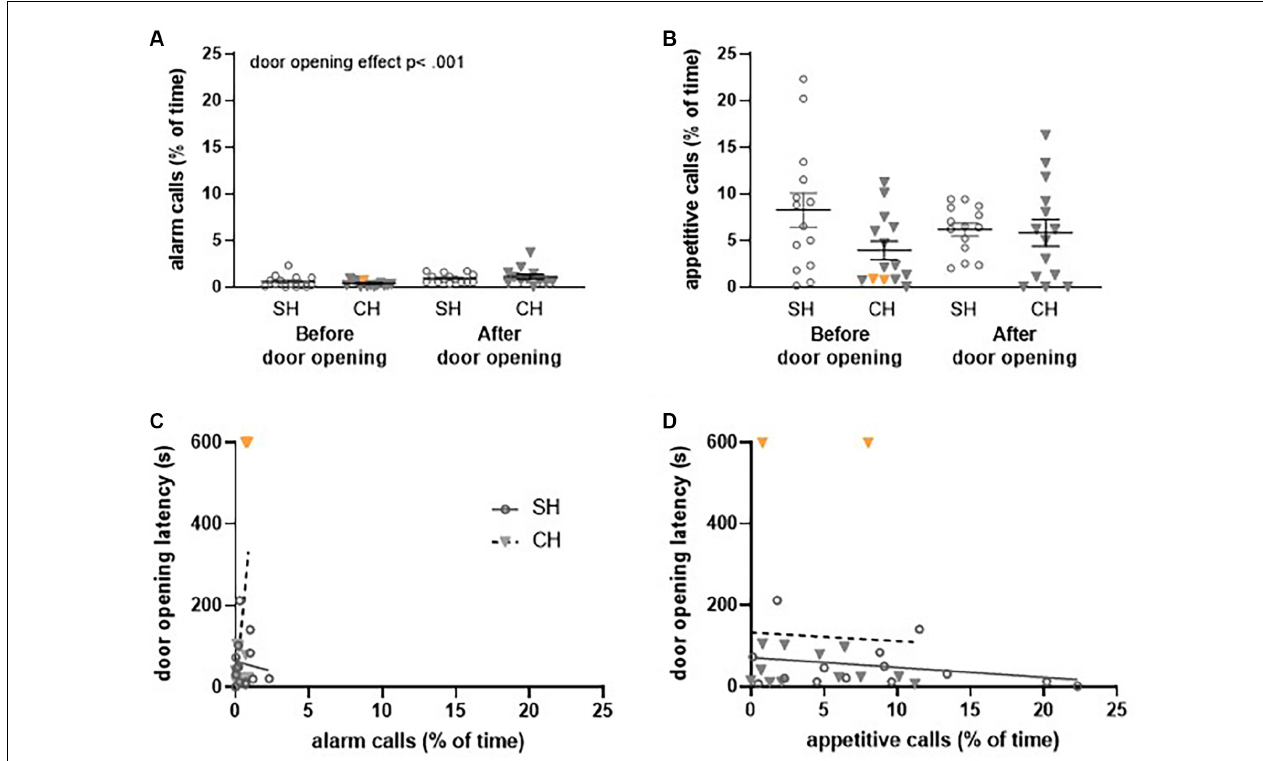
FIGURE 7 | Ultrasonic vocalizations (USVs) recorded during the first (FR1) trial of the Not Trapped configuration in the complex housing experiment. Vocalizations are presented as the percentage of time rats emit these USVs. Per experimental group, 14 pairs of rats were included of which two rats (complex housed) did not open the doors (data points depicted in orange). (A) 22 kHz (alarm) calls and (B) 50 kHz (appetitive) calls before and after door opening for standard and complex housed rats. (C) The relation between 22 kHz vocalizations (before door opening) and door opening latency and (D) the relation between 50 kHz vocalizations (before door opening) and door opening latency. SH, standard housed (black line); CH, complex housed (dashed line). It should be noted that the number of time animals emitted alarm calls was very low in this configuration. For this reason, the scaling of Figure 7 differs slightly from Figure 6 . Data represent individual data points and mean ±